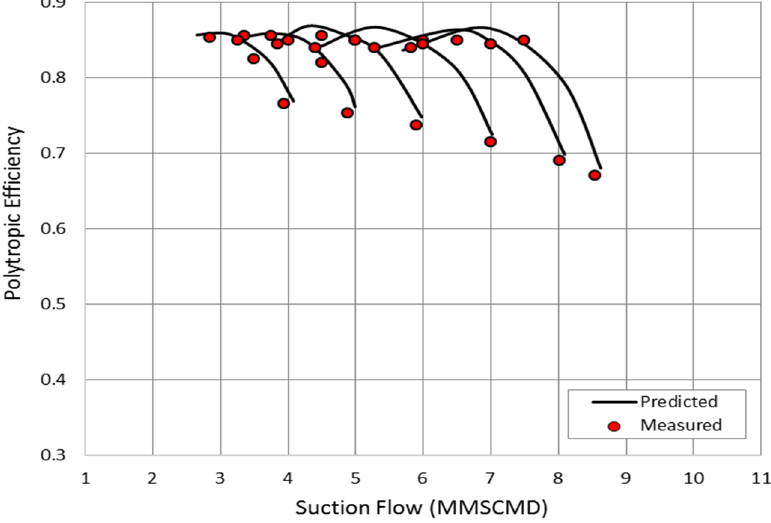
Figure 6. Comparison between the predicted and measured polytropic efficiencies.